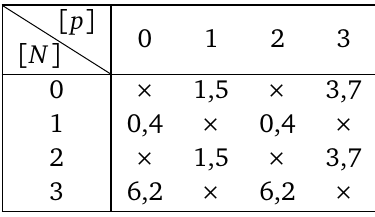
Table 2: The chiral central charge c computed from (2.18). For each case c depending on [ N ] = N mod 4 and [ p ] = p mod 4. Here × means that the theories with such p and N do not exist according to the conditions that pN is even and gcd ( N , p ) =